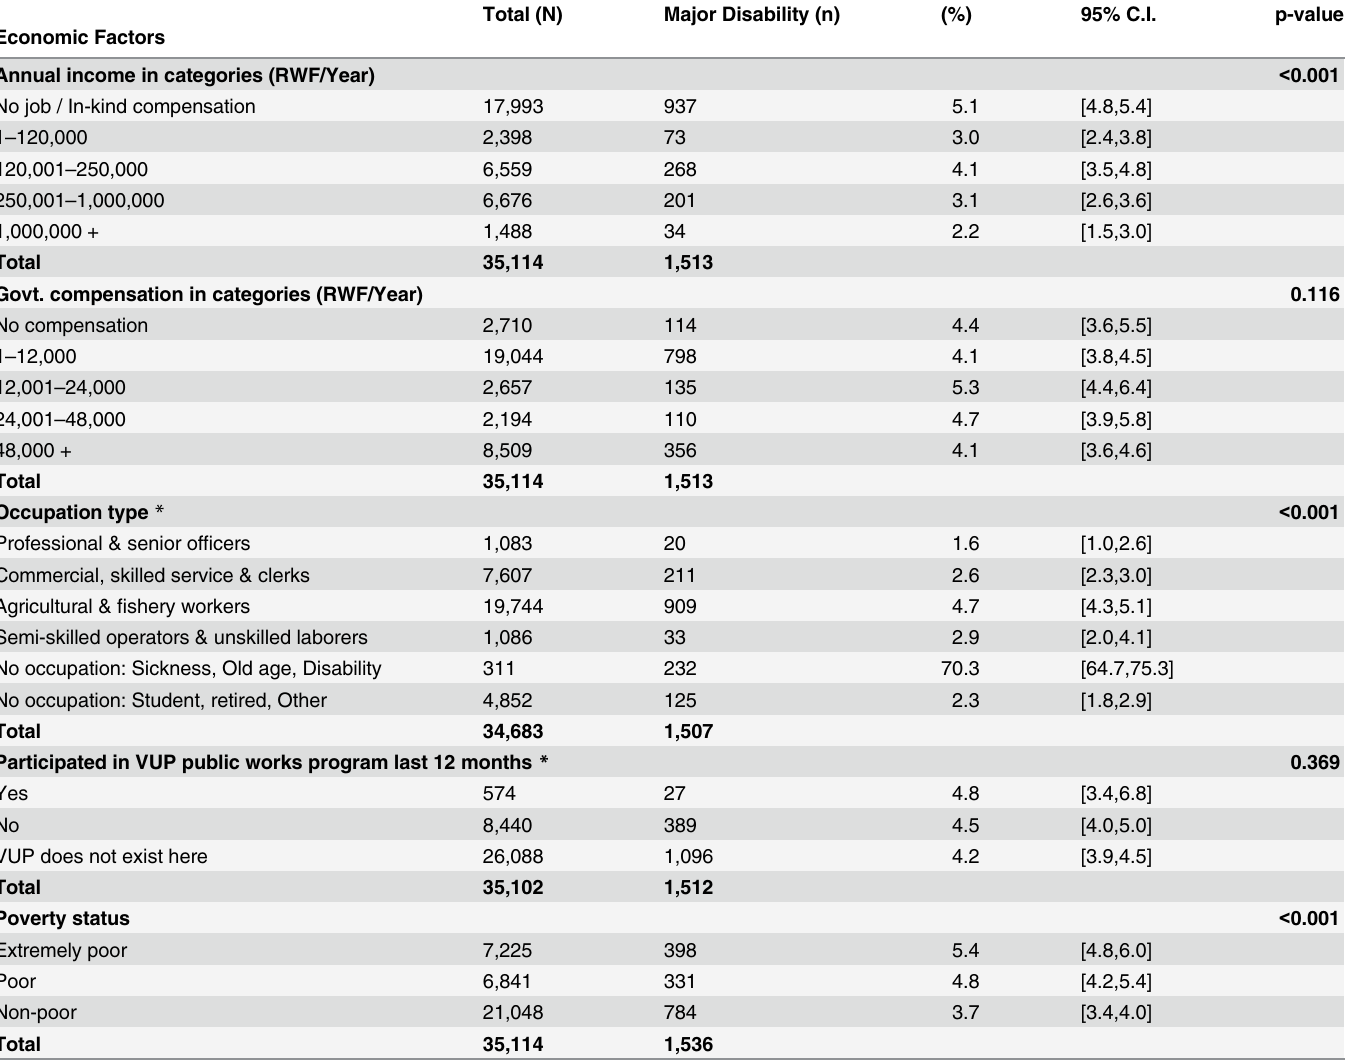
Table 2. Bivariate Associations Between Socio-Economic Factors and Major Disability in Rwanda,